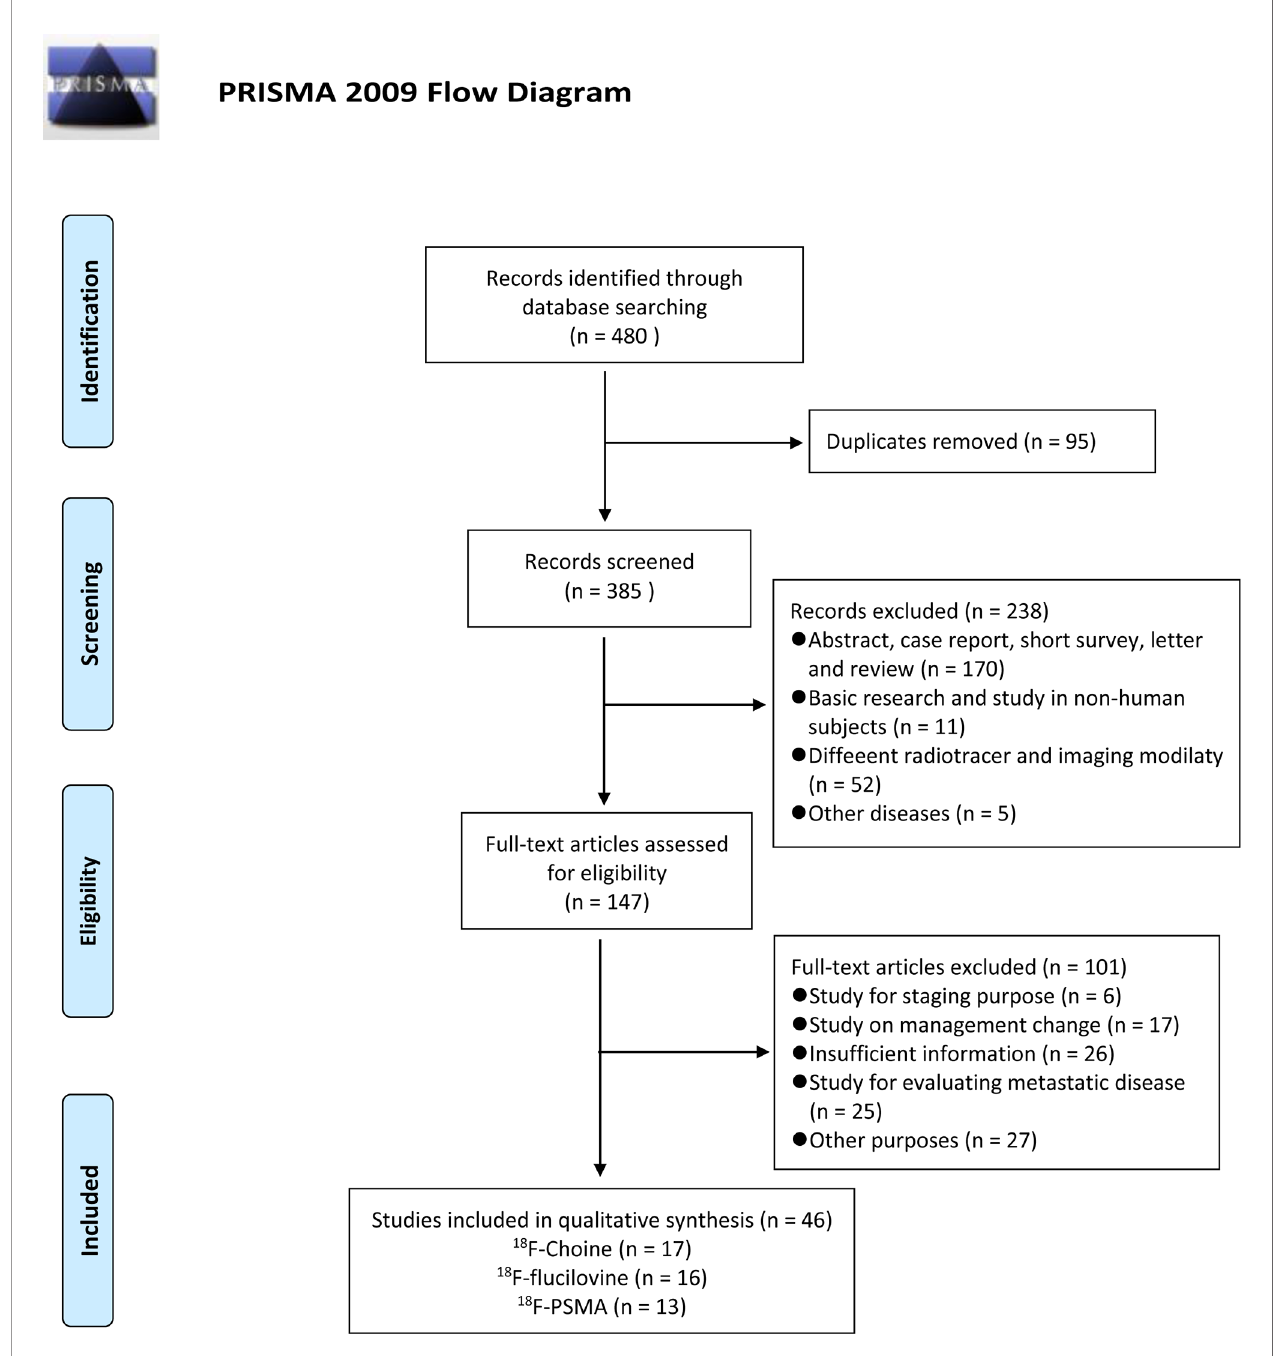
FIGURE 1 | Flow of study